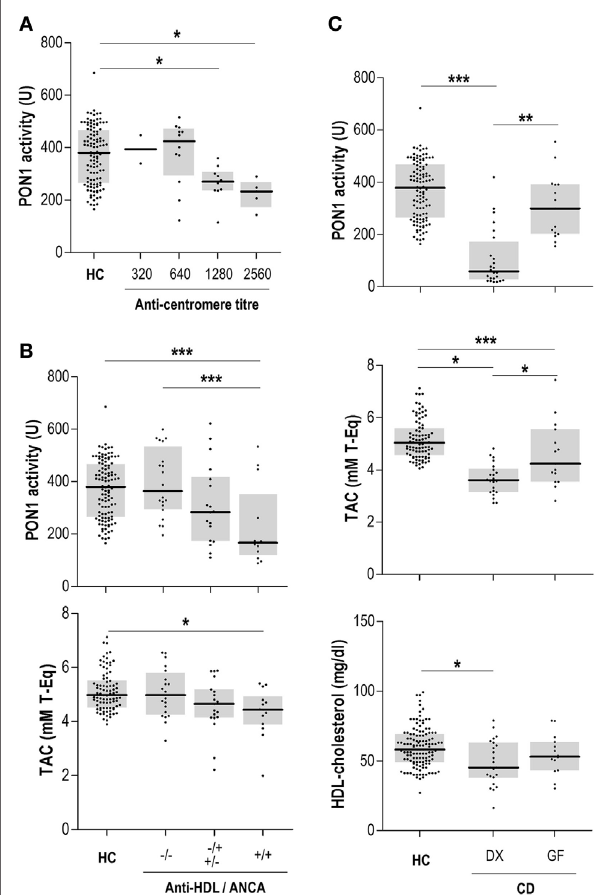
FigUre 3 | Anti-high-density lipoprotein (HDL) antibodies, disease- related autoantibodies, and paraoxonase 1 (PON1) activity. (a) Association between anti-centromere titer and serum PON1 activity in systemic sclerosis patients. (b) Association between anti-HDL and anti-neutrophil cytoplasm antibodies (ANCA) positivity and PON1 activity and serum total antioxidant capacity (TAC) in IBD/UC patients. (c) PON1 activity, serum TAC, and HDL levels in celiac disease (CD) patients recruited at diagnosis (DX) or those under a strict gluten-free diet (GF). Each dot represents one subject, whereas horizontal bars represent the median value and gray boxes delimit 25th and 75th percentiles. Differences were assessed by Kruskal–Wallis test and Dunn–Bonferroni correction for multiple comparisons test. Statistical significance is indicated as * p < 0.05, ** p < 0.010, and *** p < 0.001.